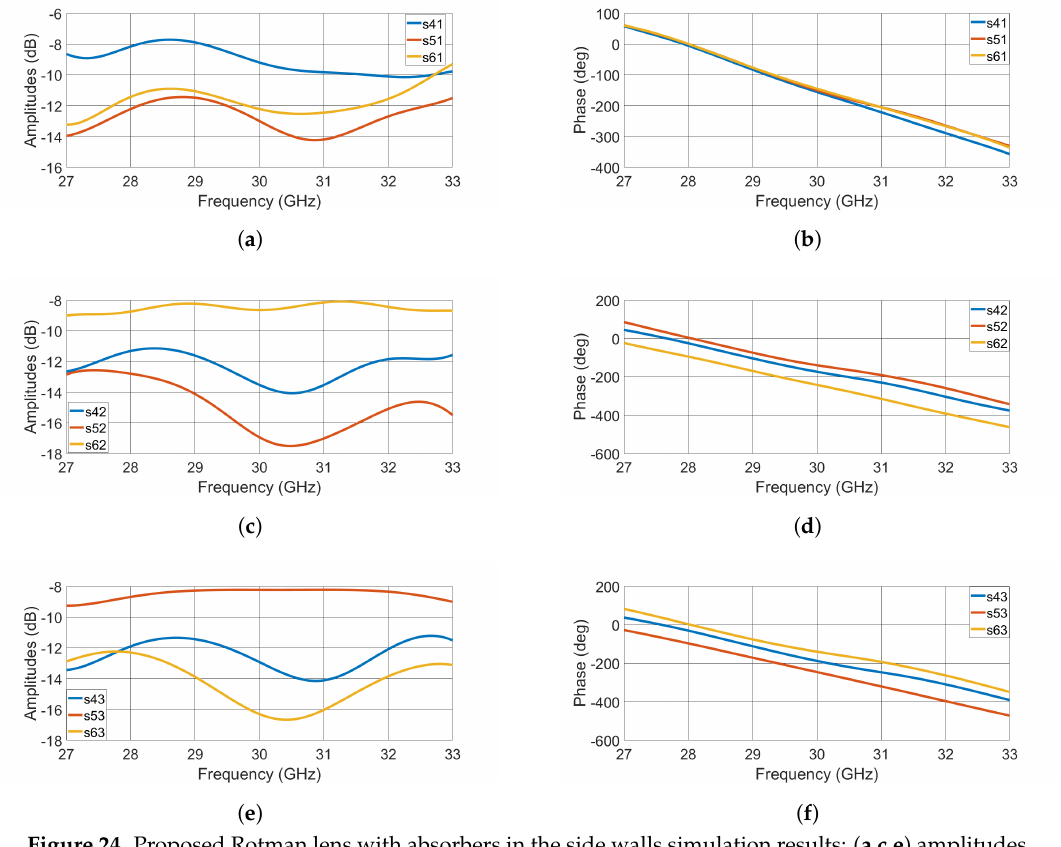
Figure 24. Proposed Rotman lens with absorbers in the side walls simulation results: ( a , c , e ) amplitudes | S | for the i = 1–3 outputs when the input ports j = 1,2, 3 are excited; and ( b , d , f ) group delay for the ij i = 1–3 outputs when input ports j = 1,2,3 are excited.